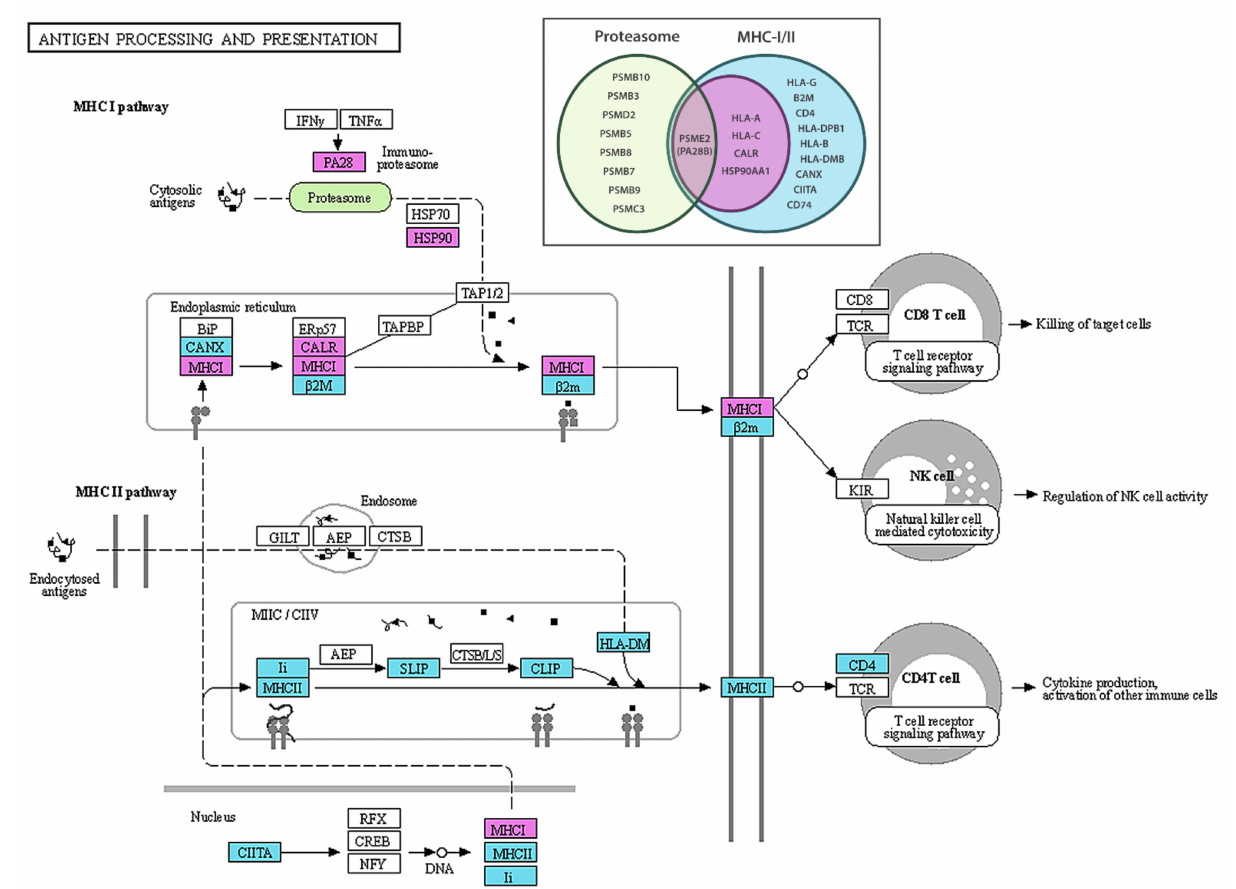
Figure 2. Illustration of the antigen processing and presentation KEGG pathway . Upregulated DEGs detected by rank product statistics are filled with magenta ( HLA-A and HLA-C are here collectively referred to as MHCI ; HPS90 is a short for HSP90AA1 ; and PA28 is an alias for PSME1-2-3 ). In cyan are the elements of the pathway additionally detected by the GSEA leading edge analysis. The GSEA also revealed a significant involvement of the proteasome complex (in green). Using the same colour code, the Venn diagram in the upper inset shows the complete lists of the official gene symbols found to be upregulated within the two KEGG pathways. The KEGG pathway map is hsa04612-antigen processing and presentation—Homo sapiens (human), modified and published with permission from Kanehisa Laboratories as the copyright